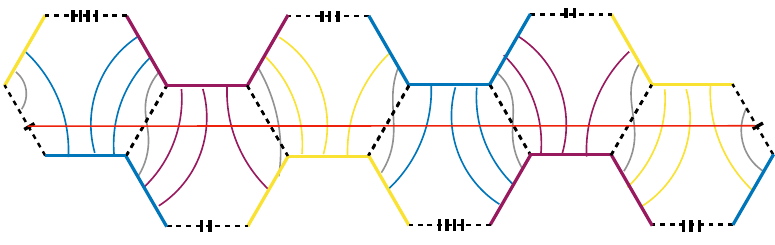
Figure 13 . Using the flows from figure 3 we can create a constructed flow on P which saturates on Σ P . The threads which began on O (shown in grey) can be identified across the boundaries because of the original constraint α = n µ v µ | O . It is these threads which cross between the original A i copies of the geometry which should be thought of as representing the entanglement which is “truly” multipartite. Note because of how this flow was constructed there are no loops of threads and no threads connecting a boundary of P back to the same boundary (for example a thread starting and ending on A ). This guarantees that this flow is in fact a multiflow. This is important as it shows there are maximal multiflows in the space of feasible points of the maximization program used to find optimized flows on P